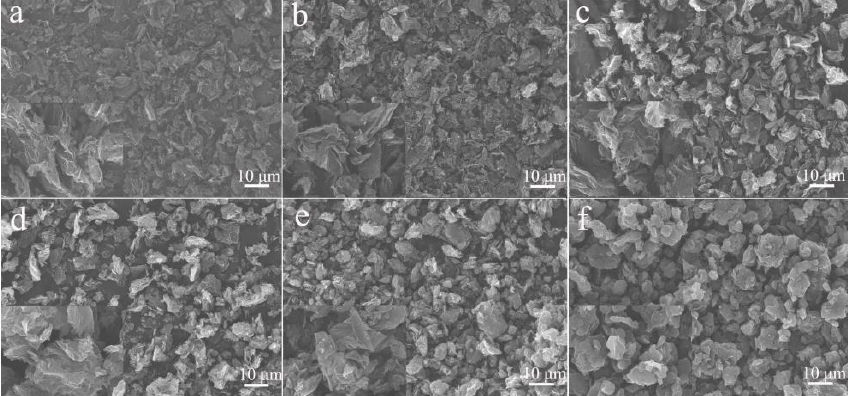
Figure 4. SEM images of rGO ( a ), GESA1 ( b ), GESA2 ( c ), GESA3 ( d ), GESA4 ( e ), and GESA5 ( f ) composites.